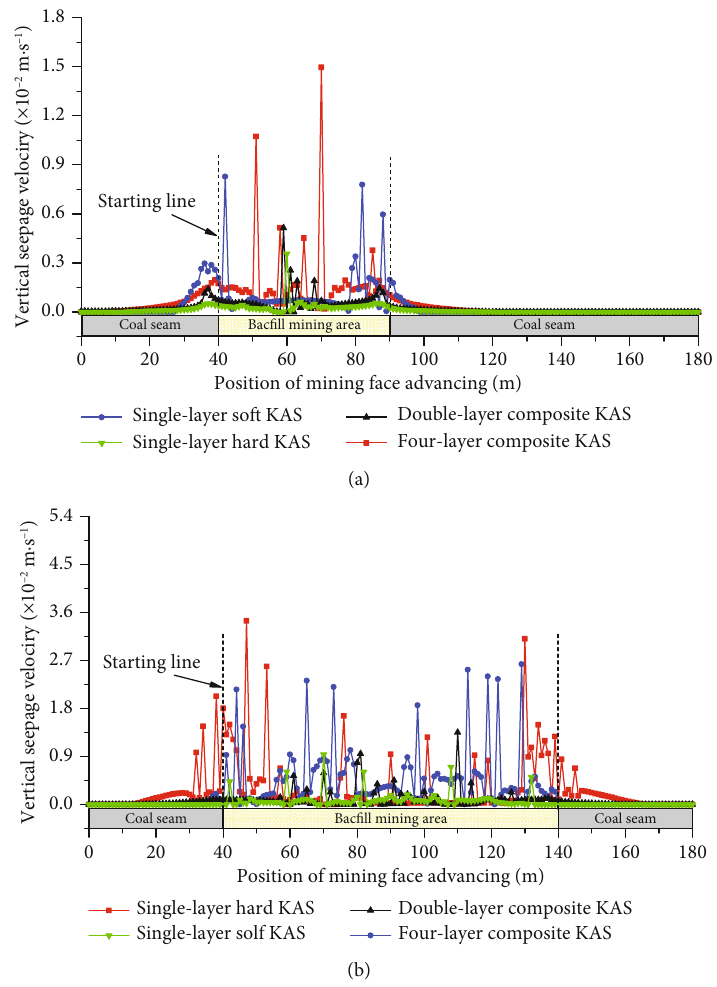
Figure 4: Vertical seepage fl ow distribution of KAS with di ff erent structural features: (a) advancing distance 50m; (b) advancing distance